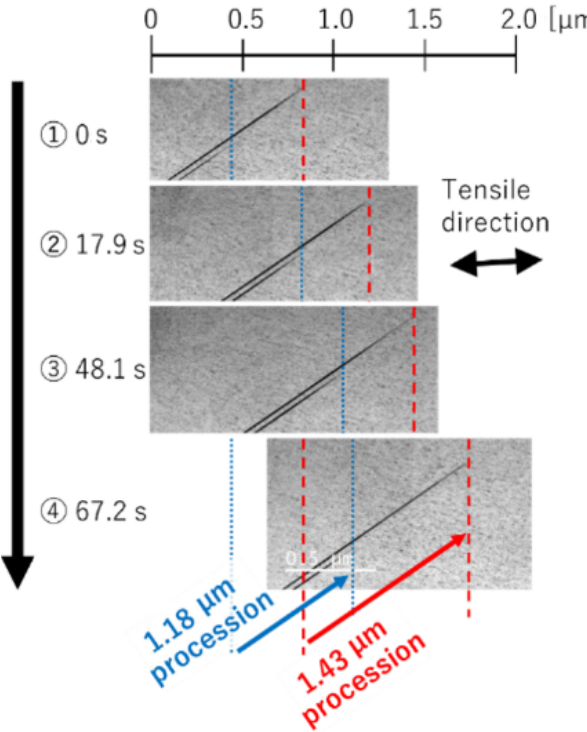
Figure 3. Time-sequential changes in TEM images during the dynamic observation for procession of edge-on dislocation. Two extended dislocations are in motion.